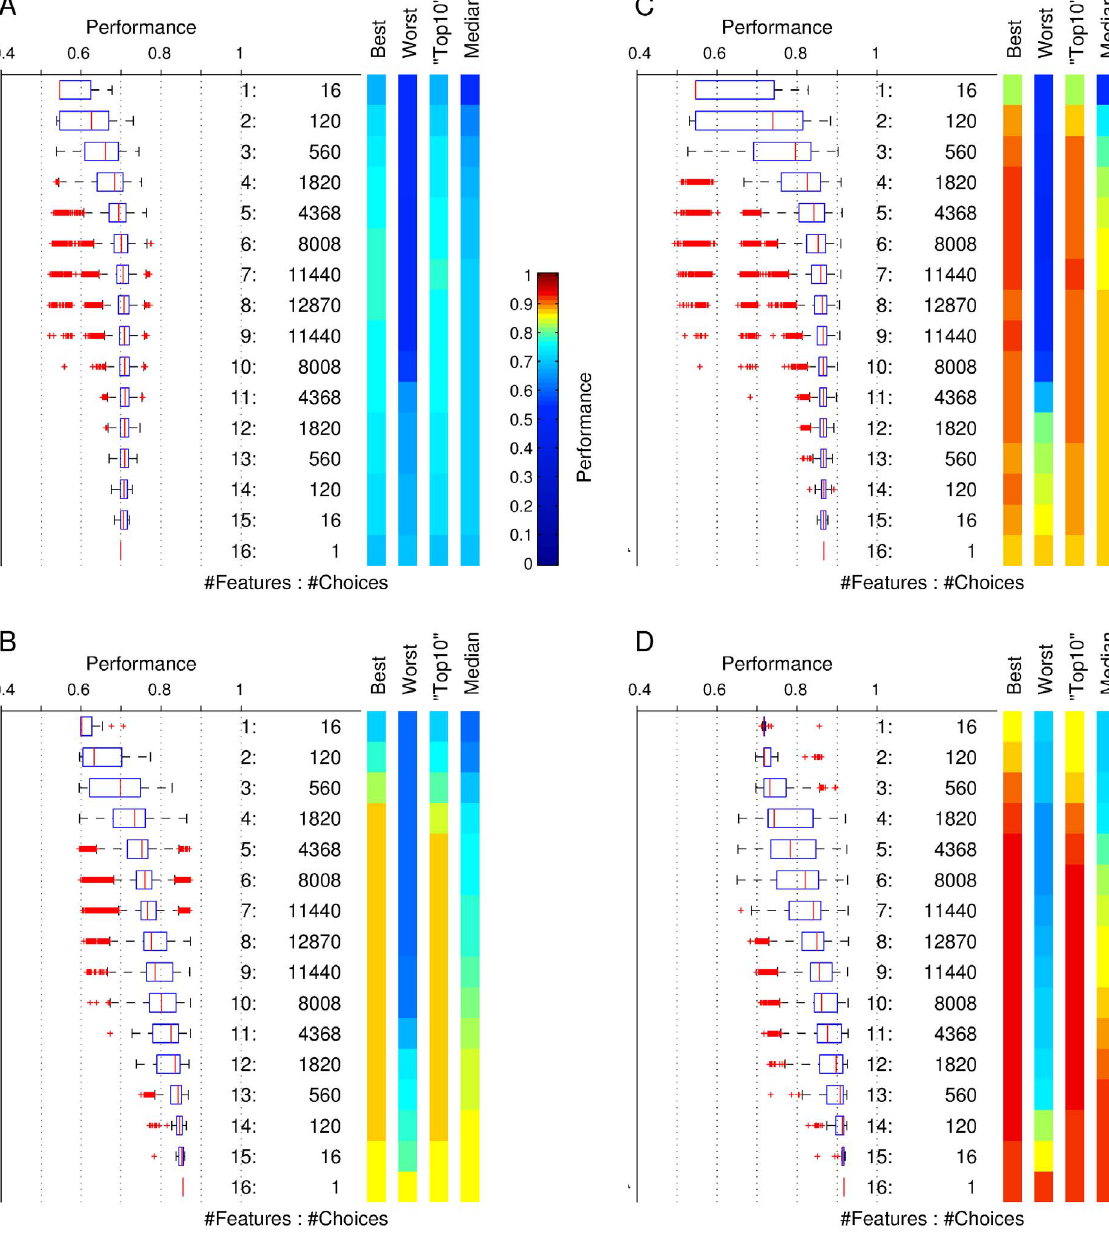
Figure 5. Crossvalidation performance as a function of the number of chosen features. The boxplots represent the distribution of observed fraction of correct classification for all feature choices of n features, with n ranging from 1 feature (top line) to all 16 features (bottom), see labels in the middle column. The colour bars indicate the performance for the best, worst, top10 (see main text for definition) and median feature choice. Panel A and C show the performances for classifying all three categories of good, intermediate and bad for data set 1 (A) and data set 2 (C). Panels B and D show the results for classifying ‘‘good’’ against the combined category of ‘‘intermediate or bad’’.